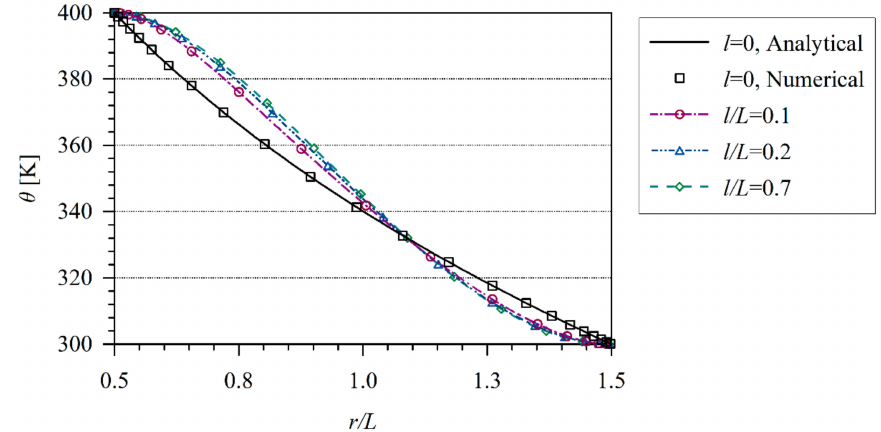
Figure 7. Temperature variation along non dimensional x / L coordinate in hollow cylinder.